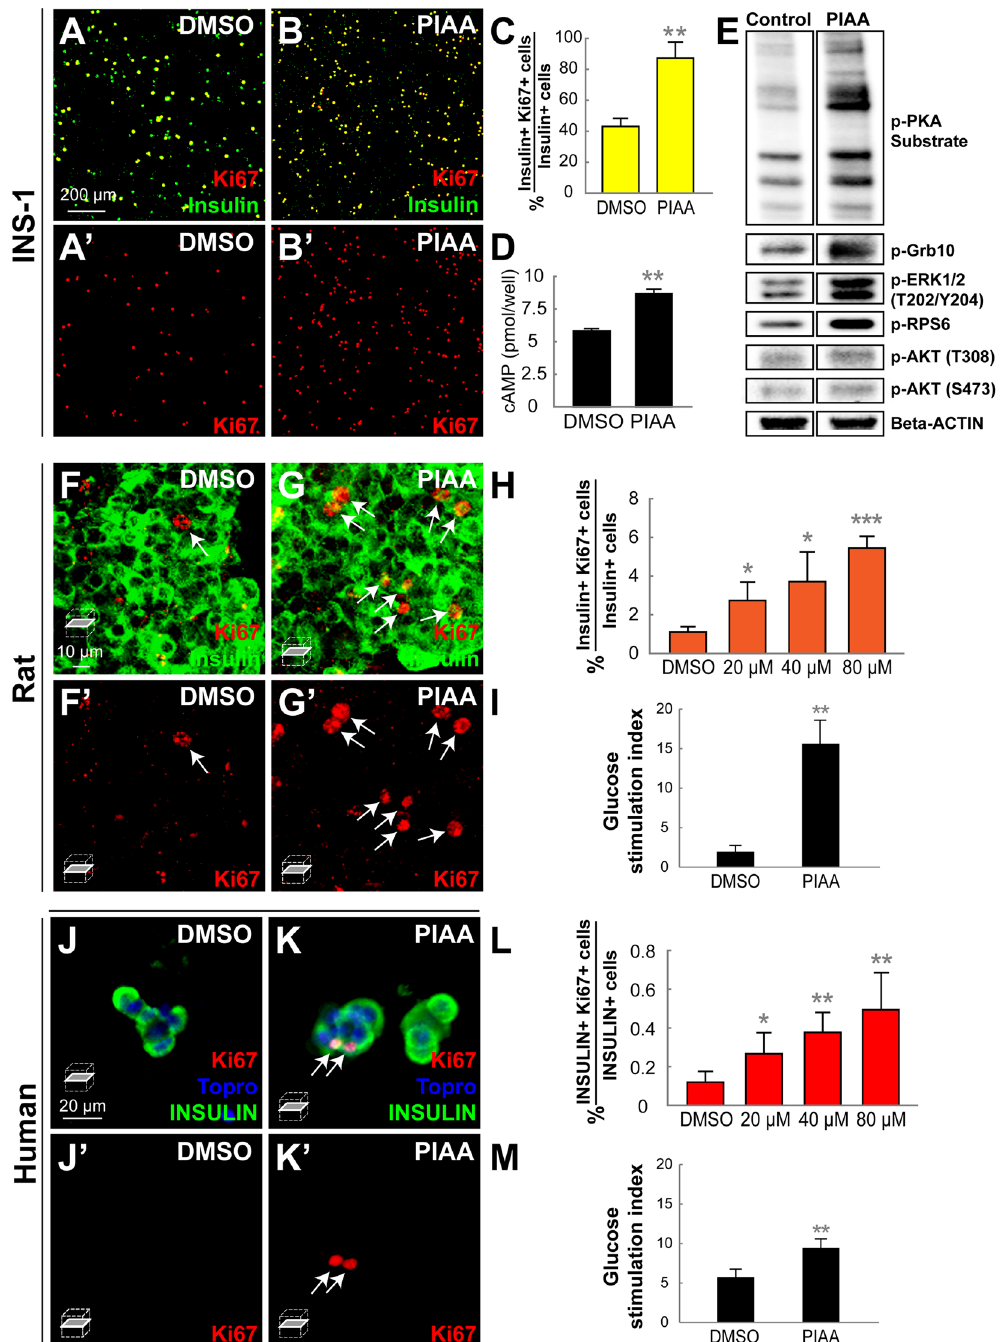
Figure 7. PIAA induces proliferation of rat and human β -cells. ( A-B’ ) Confocal images of rat INS-1 β -cells treated with DMSO ( A-A’ ) and PIAA ( B-B’ ), respectively, stained for Ki67 (red) and Insulin (green). ( C ) The percentage (mean ± SD) of Ki67 and Insulin-double positive cells (in A-B’; 43.1 ± 5.2% (DMSO) and 87.3 ± 10.4% (PIAA)). ( D ) Quantification of cAMP levels (mean ± SD) (5.8 ± 0.2 pmol/well (DMSO) and 8.7 ± 0.4 pmol/well (PIAA)). ( E ) representative Western blot showing increased phosphorylation of PKA substrate and ERK1/2 in PIAA-treated INS-1-derived 832/13 β -cells. Note that PIAA-treatment augmented phosphorylation of mTOR targets RPS6 and Grb10 but did not trigger phosphorylation of AKT T308 and AKT S473 . ( F-G’ ) Confocal single- plane images of whole rat islets treated with DMSO ( F-F’ ) and PIAA ( G-G’ ), respectively, stained for Ki67 (red, white arrows) and Insulin (green). ( H ) The percentage (mean ± SD) of Ki67 and Insulin-double positive cells in whole rat islets increased in a dose-dependent manner with treatment of PIAA (1.1 ± 0.3% (DMSO), 2.7 ± 0.9% (20 μ M), 3.7 ± 1.5% (40 μ M), and 5.5 ± 0.6% (80 μ M)). n = 5 replicates per condition. ( I ) Glucose stimulation indices of rat islets treated with DMSO or PIAA (300 islet equivalents per column, triplicate). ( J-K’ ) Confocal single-plane images of human islets treated with DMSO ( J-J’ ) and PIAA ( K-K’ ), respectively, stained for Ki67 (red, white arrows), Topro (blue), and INSULIN (green). ( L ) The percentage (mean ± SD) of Ki67 and